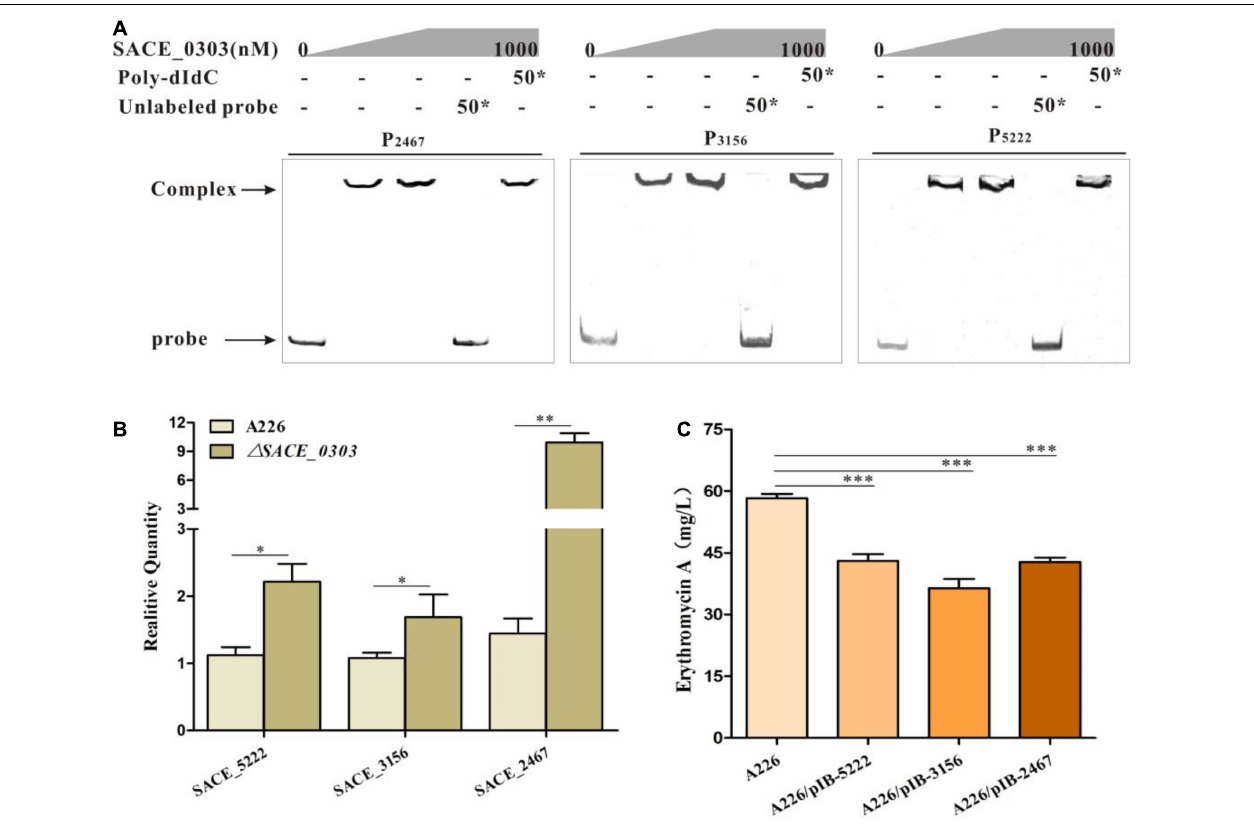
FIGURE 6 | Effects of SACE_0303 on its three targets SACE_2467 , SACE_3156 , and SACE_5222 . (A) Binding assays of SACE_0303 to P 2467 , P 3156 , and P 5222 . (B) Transcriptional analyses of SACE_2467 , SACE_3156 , and SACE_5222 in A226 and (cid:49) SACE_0303. (C) Er-A yields in A226, A226/pIB-2467, A226/pIB-3156, and A226/pIB-5222. Error bars (B,C) : SD from triplicate experiments. Statistical notations (B,C) : * p < 0.05, ** p < 0.01, *** p <